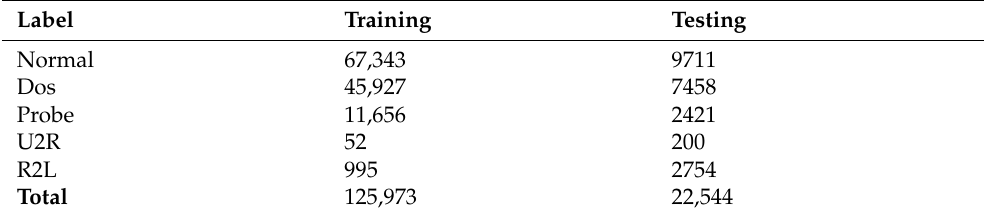
Table 2. Distribution of data on NSL-KDD (the number of